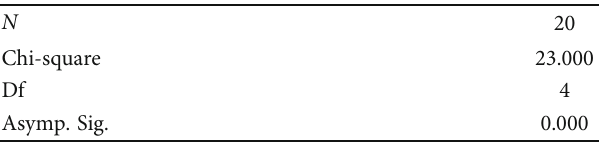
Table 2: Friedman Test statistics of di ff erent CF strategies used by